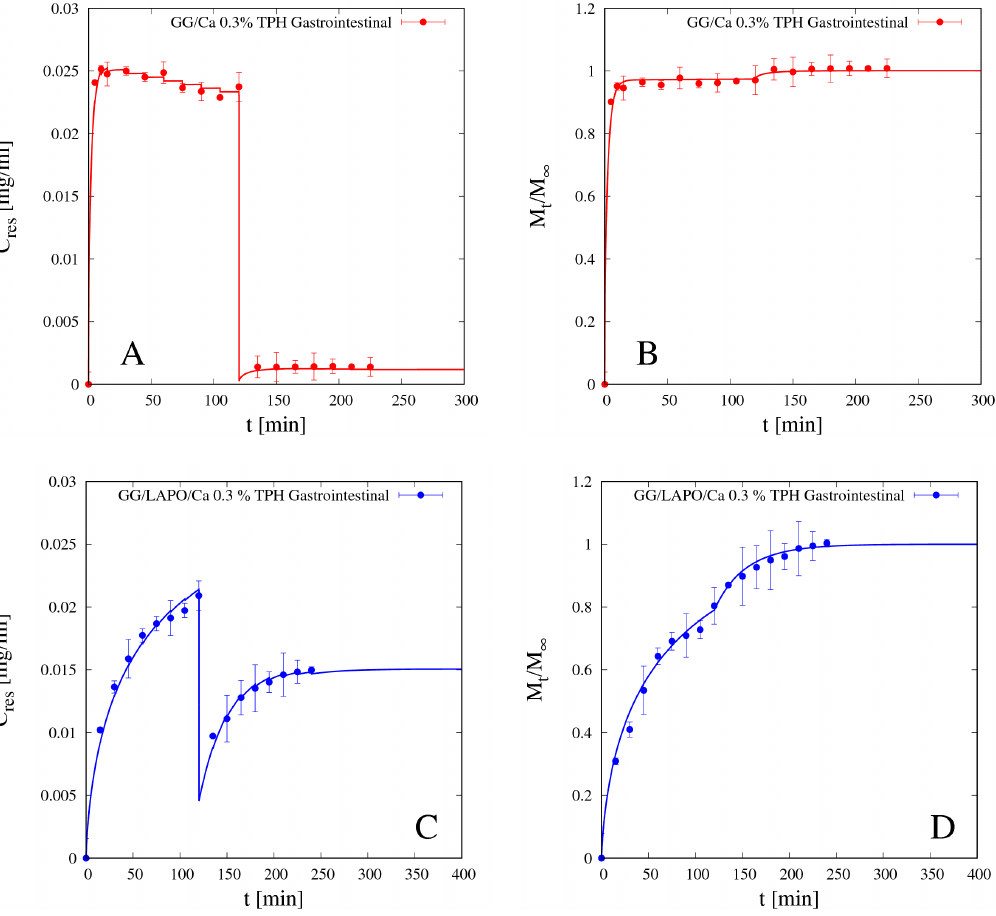
Figure 11. Gastrointestinal differential ( A , C ) and integral release curves ( B , D ) for theophylline (TPH) from beads GG/Ca 0.3% without laponite (A,B) and GG/LAPO/Ca 0.3% with laponite (C,D), p < 0.001. Continuous lines represent model predictions from Equations (11–13) with TPH diffusivity D dsg reported in Table